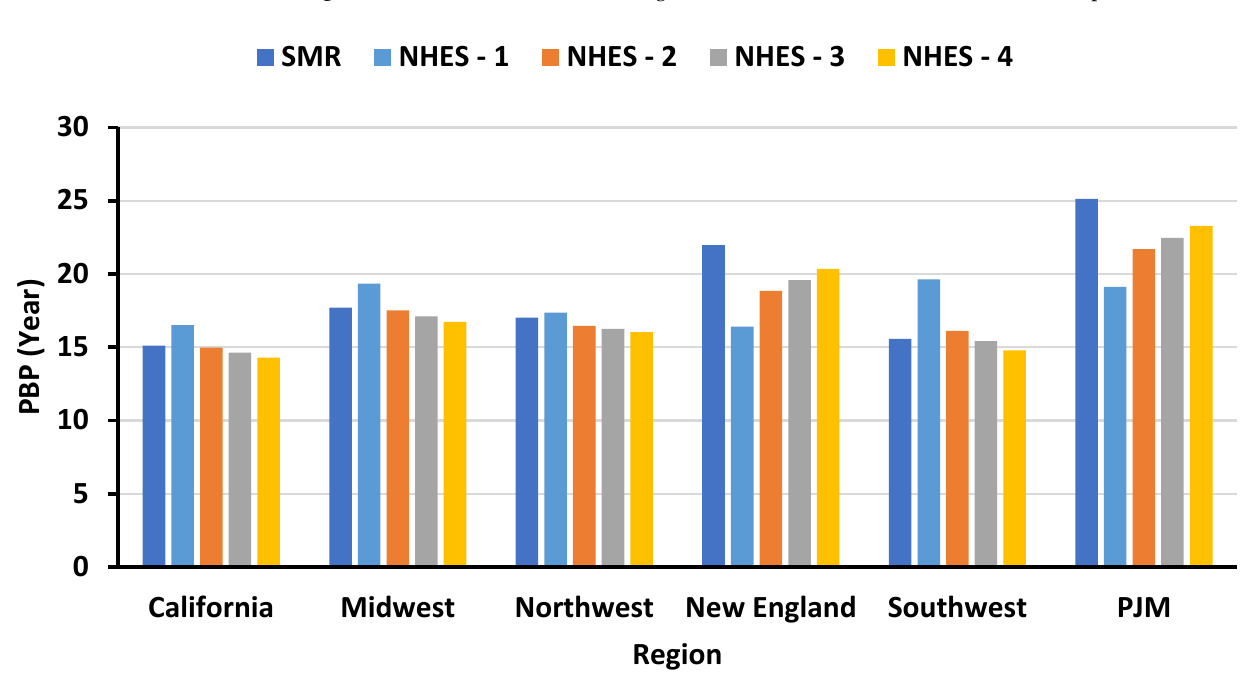
Figure 8. PBP at different regions for SMR and different SMR-ChHP output scenarios .